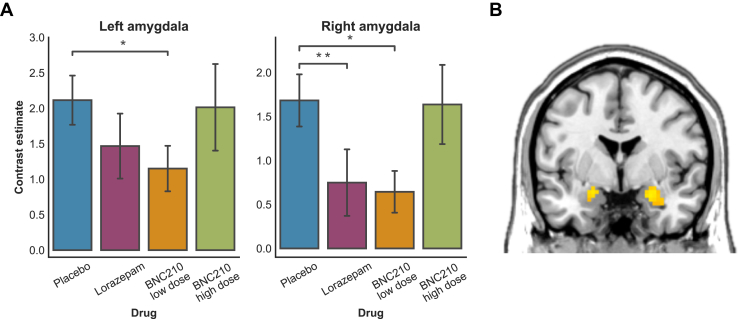
(A) Mean (±SE) amygdala response to fearful faces for each drug condition. (B) Effect of BNC210 low dose on amygdala activity, thresholded at p < .05 uncorrected for illustration. *p < .05, **p < .01.